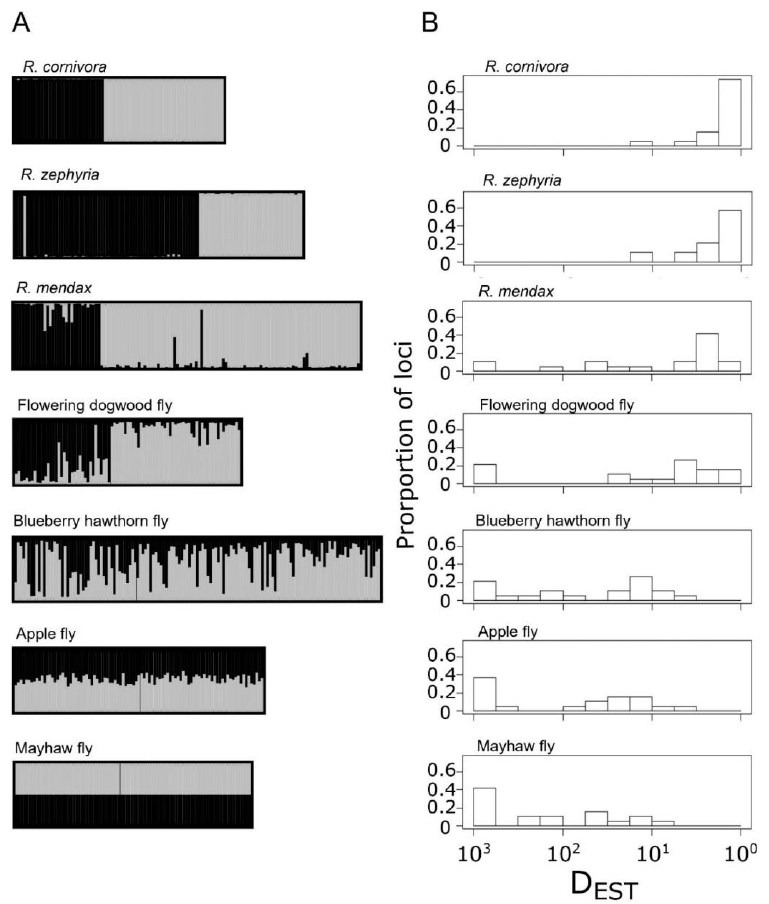
Figure 3. Patterns of genetic differentiation at paired sympatric comparisons between R. pomonella and taxa in the R. pomonella species group: ( A ) barplots of K = 2 structure analyses for each set of paired populations and ( B ) plots of the distribution locus-specific genetic differentiation for each paired population, measured as D EST .